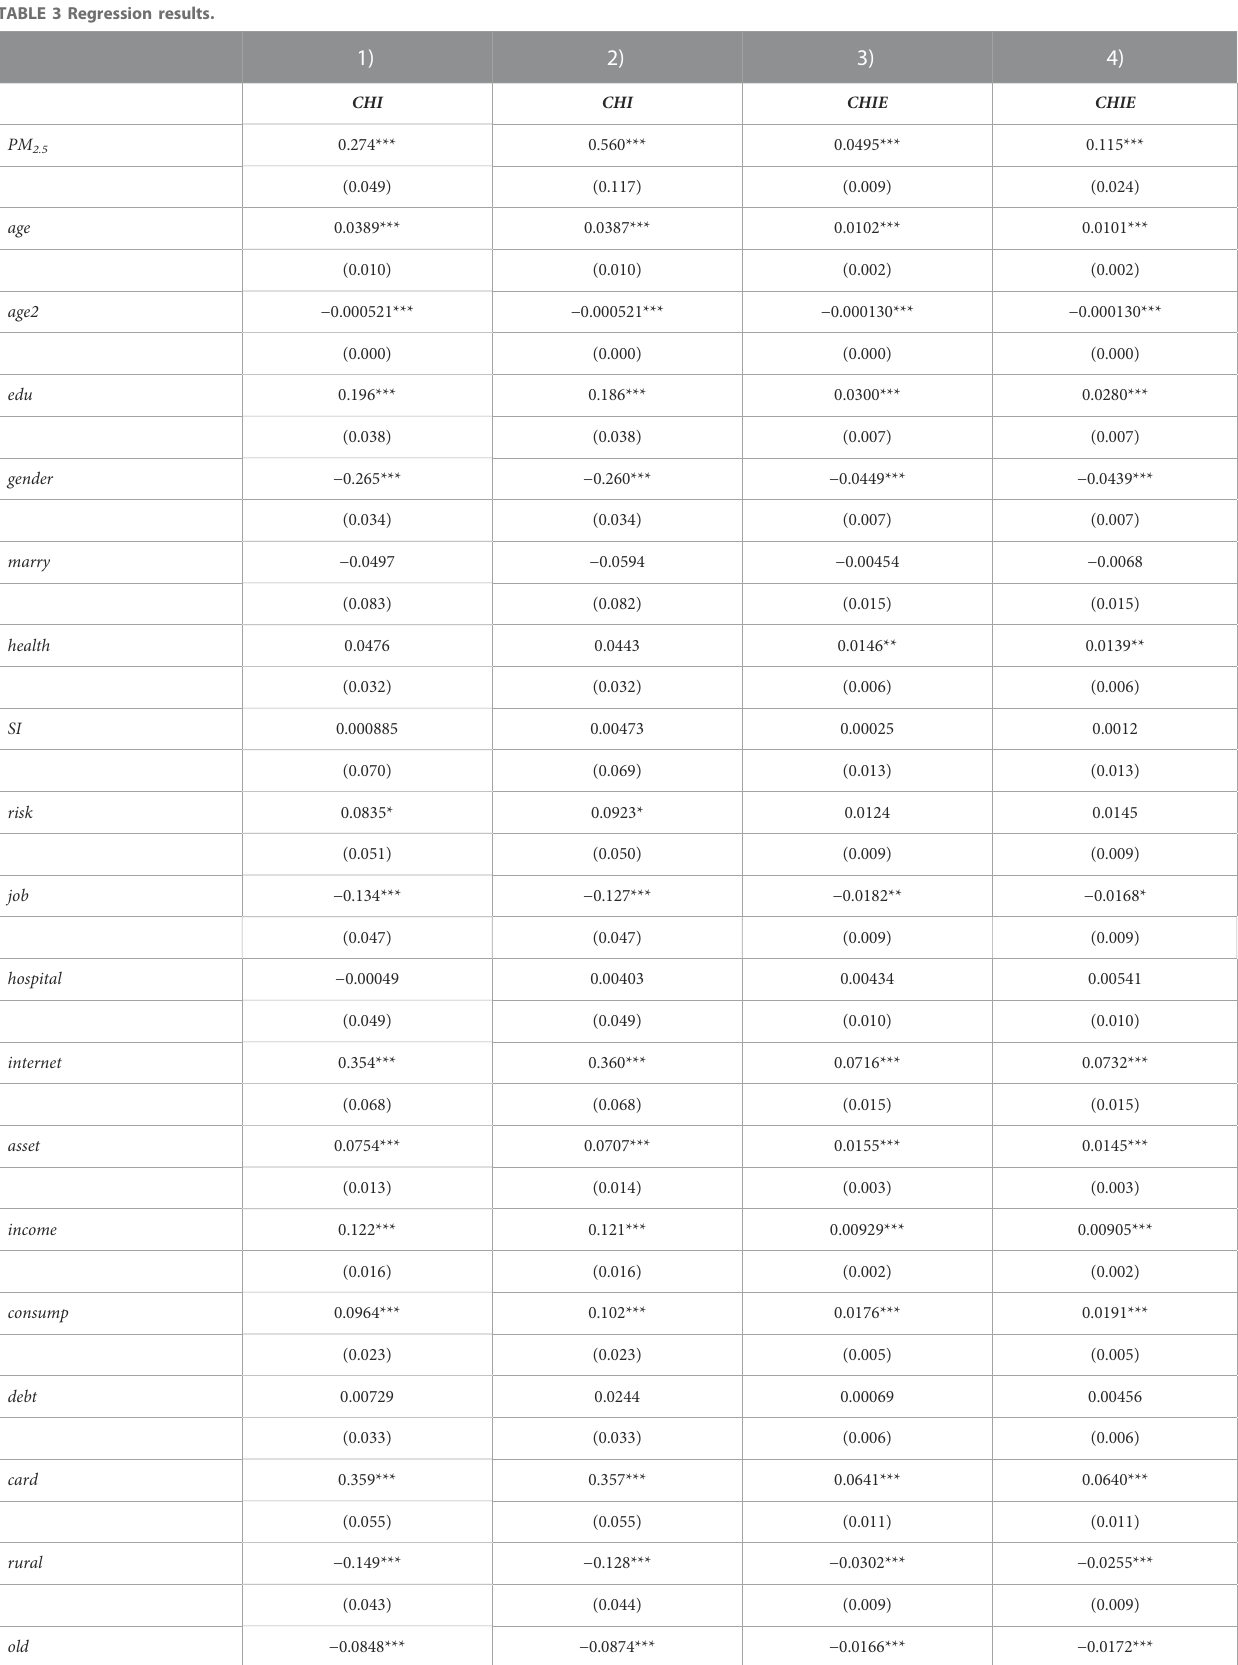
TABLE 3 Regression